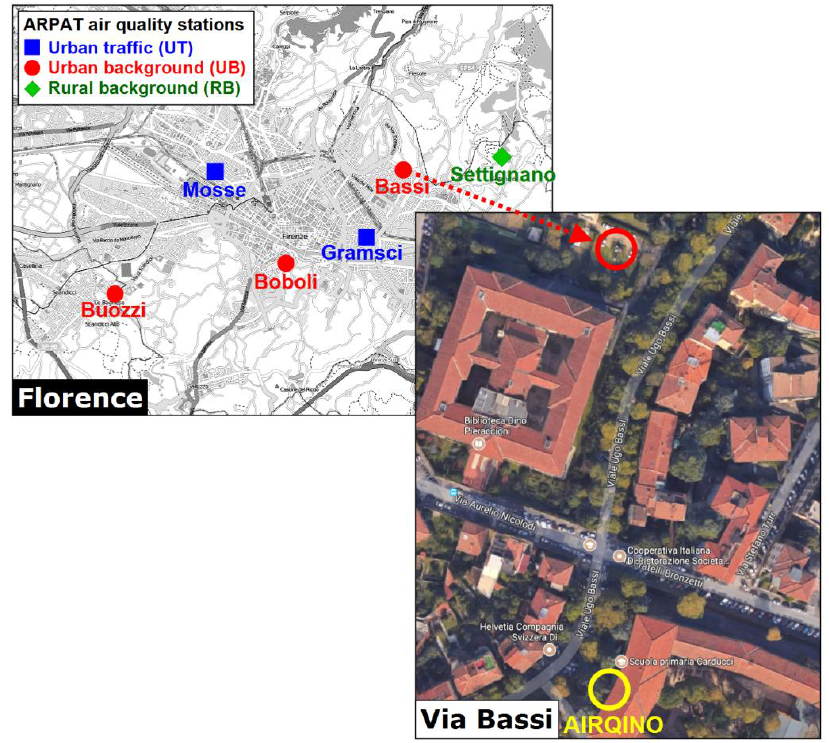
Figure 7. Map of air quality monitoring network operated by ARPAT in the city of Florence, and aerial view of via Bassi where the AIRQino PM 2.5 and PM 10 sensors were compared against the ARPAT station (Cartography sources: Bing and Google Maps).